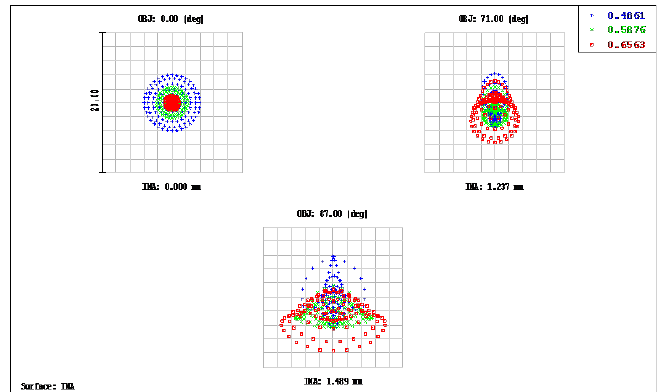
Figure 4. Spot diagram size of a miniaturized wide-angle fisheye lens using an OKP4HT aspherical lens; the figure shows the RMS spread of the images at three field angles of 0°, 71°, and 87°. The blue, green, and red dots represent the wavelengths of 0.4861, 0.5876, and 0.6563 μm, respectively.